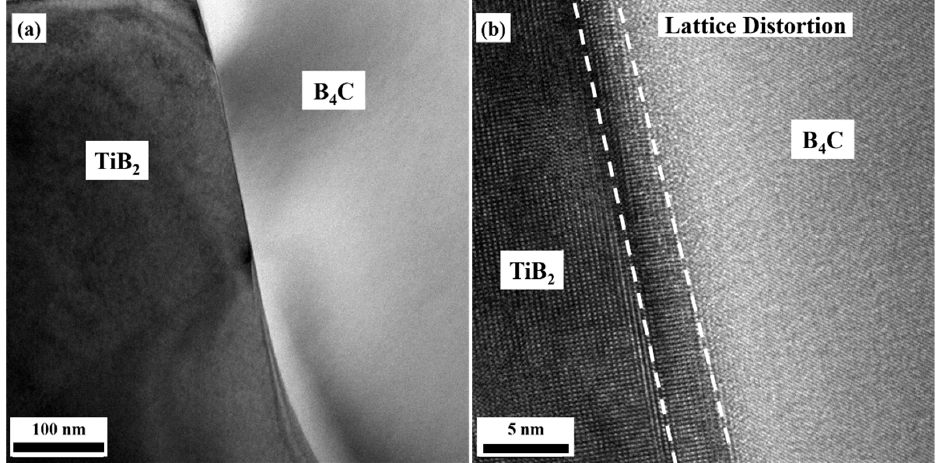
Figure 8. Interface between B 4 C and SiC. ( a ) Bright field TEM image, ( b ) SAED pattern.